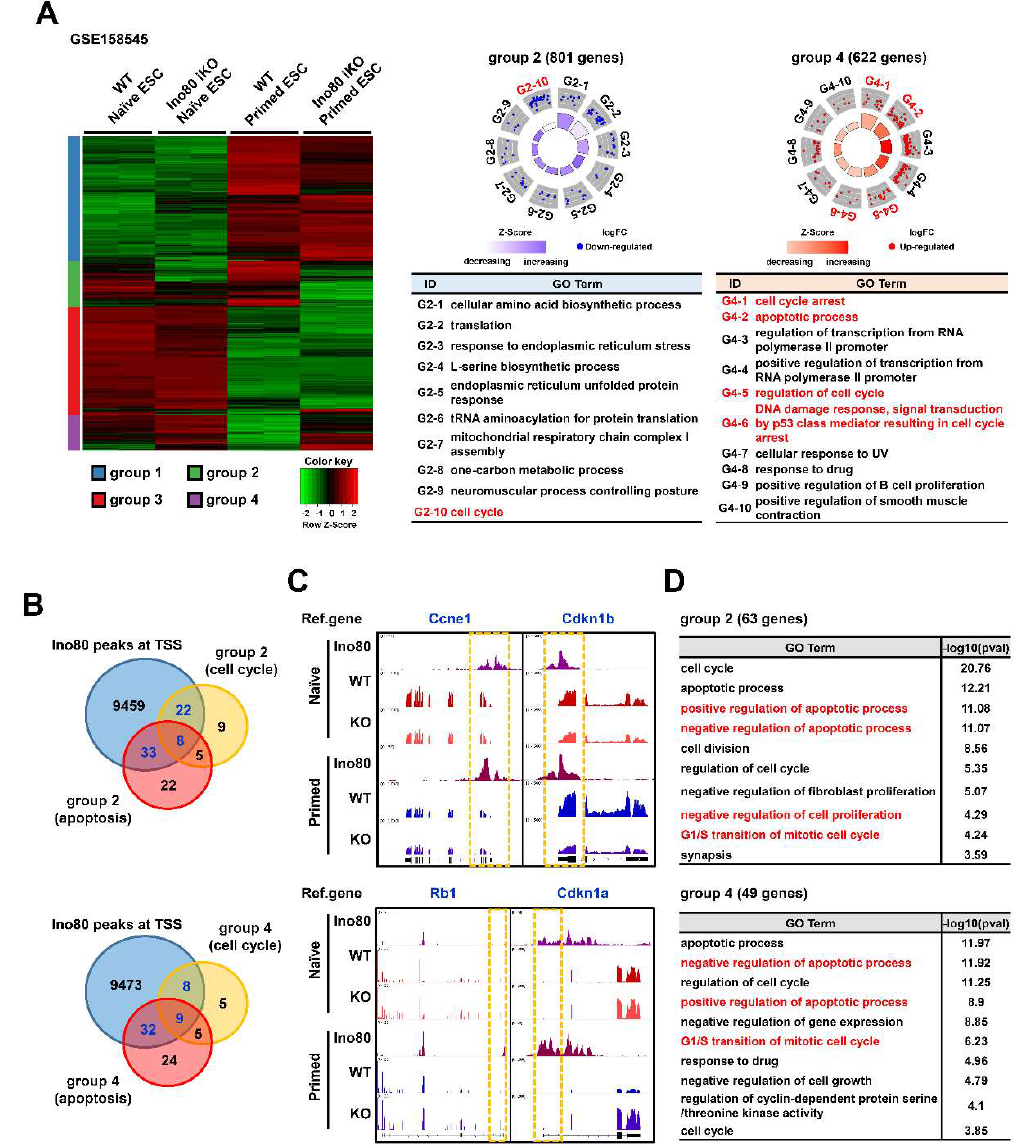
Figure 2. Ino80 directly regulates genes involved in cell cycle. ( A ) Heatmap and GO circle plot showing DEGs and GO terms of GSE158545. Unsupervised grouping with 5483 DEGs in total (cutoff value, FC ≥ 2, FPKM ≥ 2) resulted in 4 groups; group 1 (2170 genes), group 2 (801 genes), group 3 (1890 genes), and group 4 (622 genes). GOBP for group 2 and 4 genes were visualized through GO circle tool. Cell cycle- and apoptosis-related terms are highlighted in red fonts. DEGs, differentially expressed genes. GO terms, gene ontology terms. FC, fold change. FPKM, fragments per kilobase of transcript per million. GOBP, Gene Ontology Biological Process. ( B ) Venn diagram showing common genes among cell cycle, apoptosis, and Ino80 targets in the group 2 and 4. “Ino80 peaks at TSS” gene was defined as a gene which Ino80 was detected in TSS (GSE158545). Common genes are highlighted in blue fonts. TSS, transcription start site. ( C ) Visualization of representative cell cycle-related genes with Ino80 bindings and expression levels using the IGV. Yellow dotted line indicates TSS. IGV, Integrative Genomics Viewer. ( D ) GO term analysis with genes that Ino80 binds to TSS and are involved in cell cycle or apoptosis in group 2 (63 genes) and group 4 (49 genes). The tables show the GO terms and − log10( p -value). Cell cycle- and apoptosis-related terms are highlighted in red